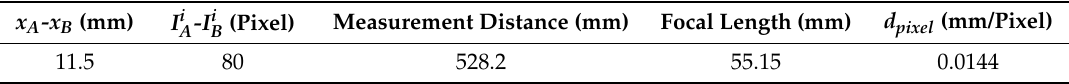
Table 8. Laboratory test